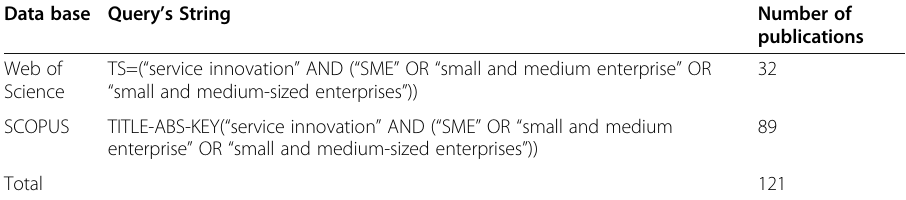
Table 1 Query ’ s String search in the databases of the structured systematic